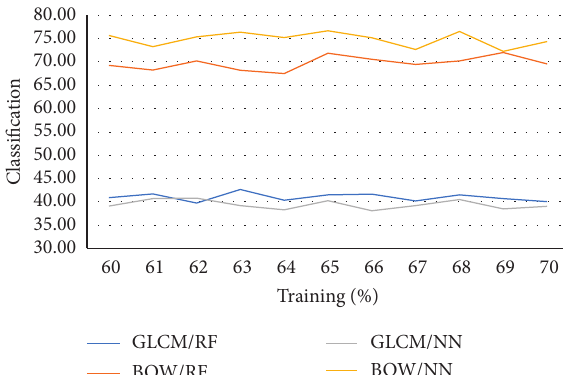
Figure 17: The classification results of GLCM and BOW methods using 60% to 70% of the training data (Yale B dataset) and the classification performance of NN and